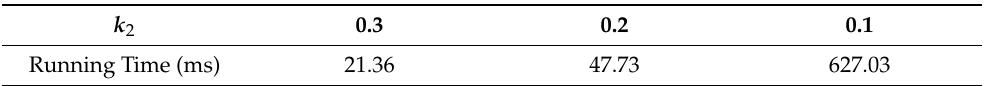
Table 4. Performance measure for real time; state of curved road, k 1 = 0.5, length 100m, and